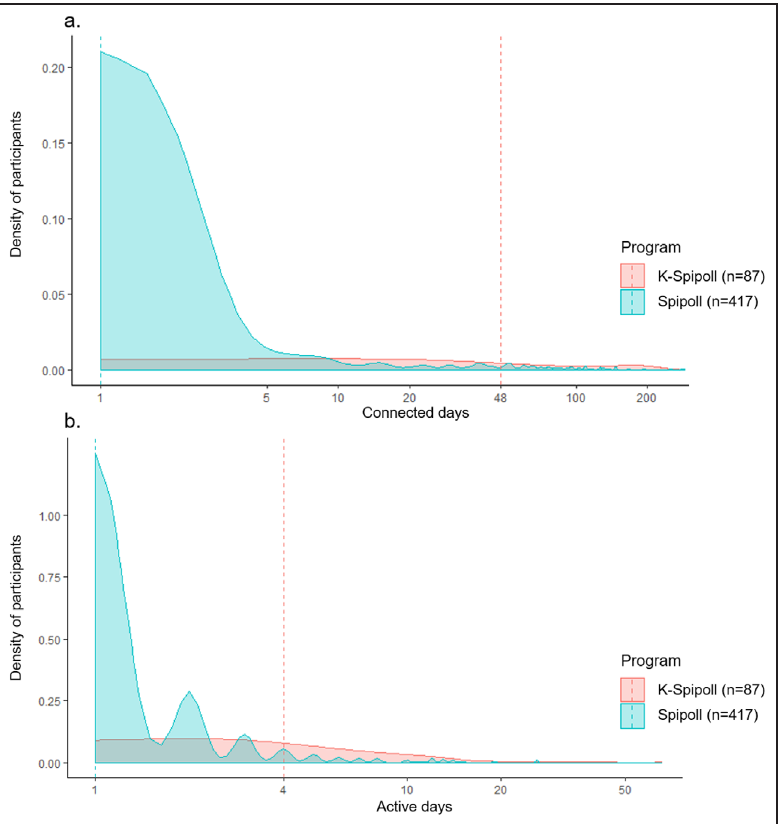
Figure 4: Number of connected (a) and active (b) days per observers for the Spipoll (blue) and the K-Spipoll (red). In each panel, dotted lines represent the median value for Spipoll and K-Spipoll (in blue and red